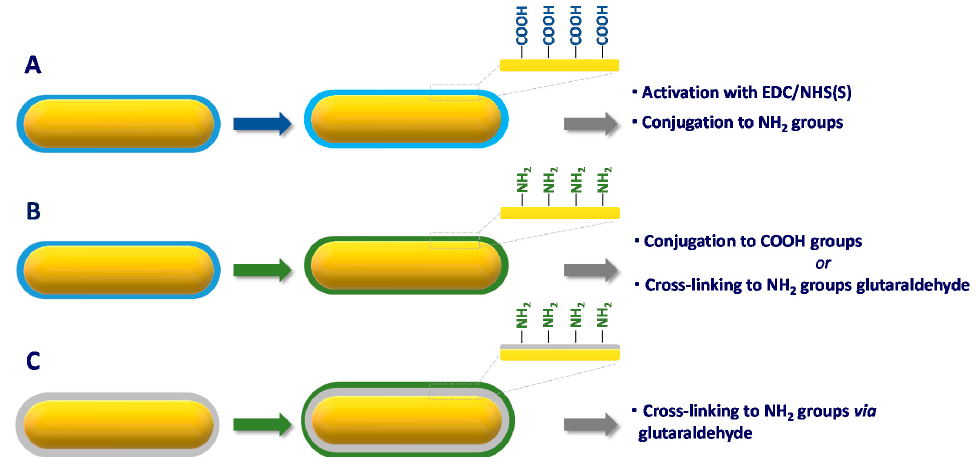
Figure 18. Covalent conjugation of bioreceptors to AuNR. ( A ) Grafting of carboxylic acids via ligand exchange; ( B ) grafting of primary amines via ligand exchange; ( C ) grafting of primary amines to silica-coated AuNR with (3-aminopropyl)trimethoxysilane (APTMS) or polyethylenimine